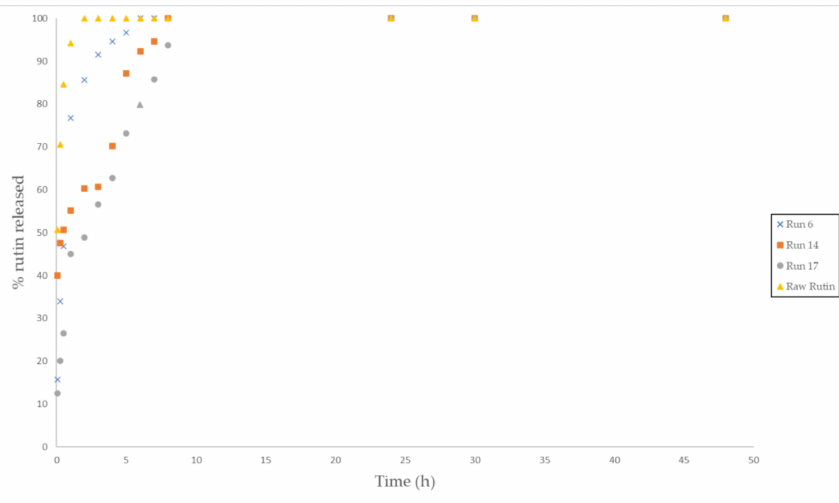
Figure 16. Rutin release profiles from the polymer foams (Runs 6, 14, 17, and raw rutin) into the PBS